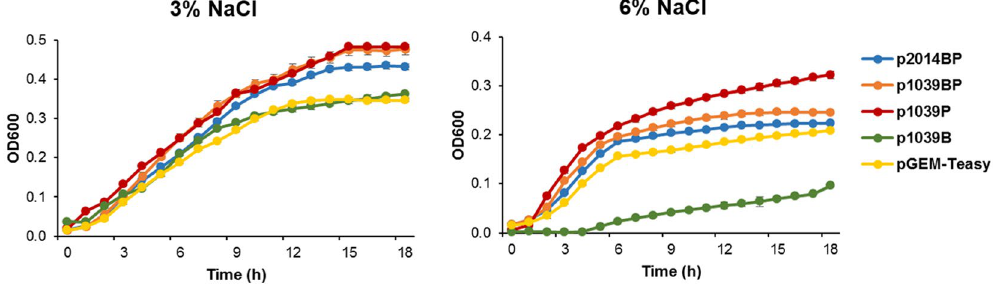
Figure 4. Effect of two types of potassium voltage-gated channel genes on the growth of E . coli cells under salt